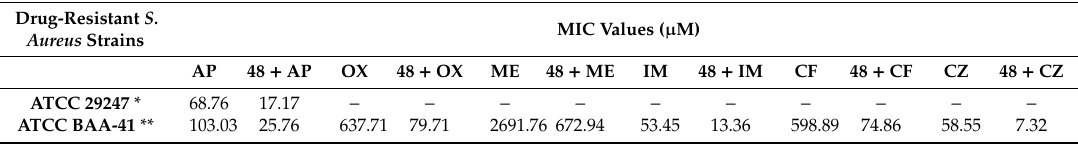
Table 8. Combination studies of quinuclidine 48 with diverse β -lactam antibiotics. Drug-Resistant S. Aureus